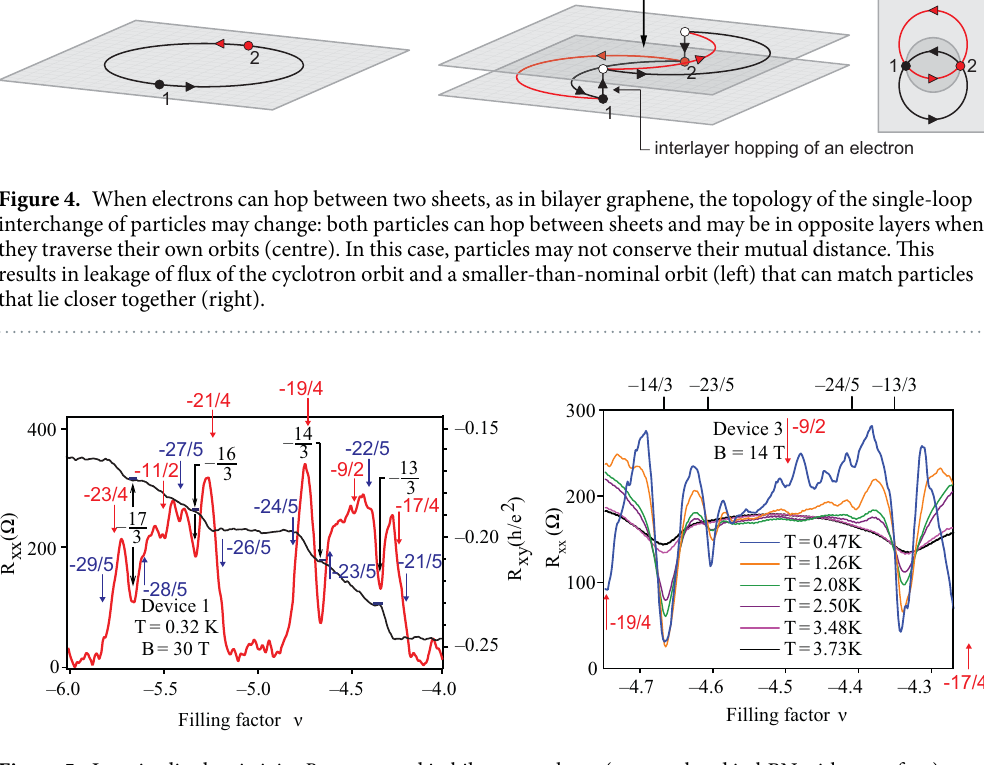
Figure 5. Longitudinal resistivity R xx measured in bilayer graphene (encapsulated in hBN with open face) for n = 2 subbands (first LL)—experiment 5 . The series of fractions with denominator 3 is consistent with the single-loop braid commensurability at the leakage of flux to the opposite sheet in the bilayer structure; the same holds for fractions with denominator 2 or 4. Fractions with denominator 5 correspond to single-loop braid commensurability for n = 2 (experiment 5 is repeated with different samples). [adapted from ref. 5 under CC-BY 4.0, coloured fractions are